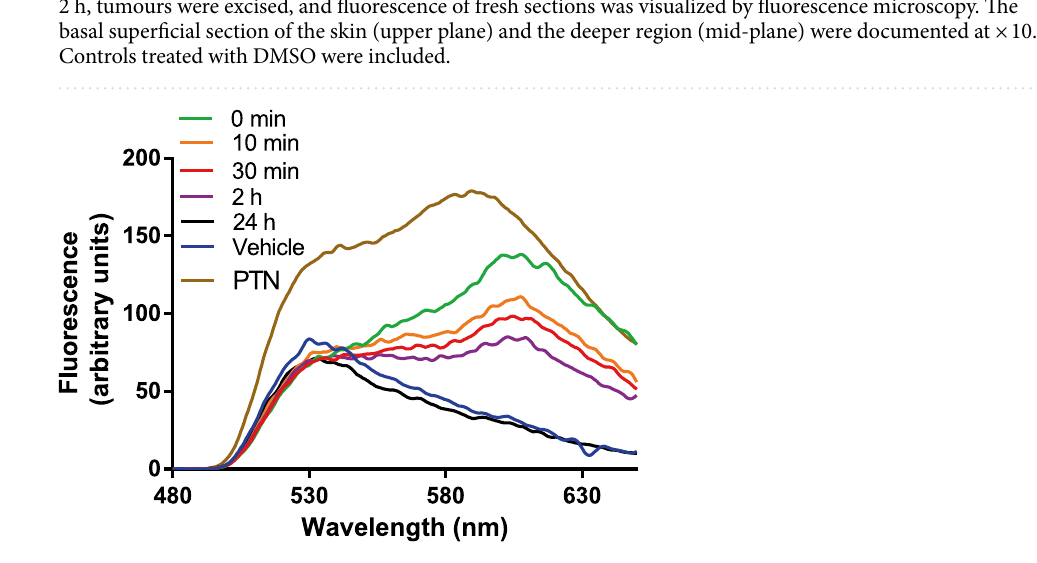
Figure 6. Kinetics of PTN penetration through the skin overlying the tumour. After topical application of PTN (1.96 mg in DMSO) on the skin over the tumour, fluorescence spectra of the AQ were recorded at the skin surface at different time points utilizing an optic fiber coupled to a spectrofluorometer. The decrease of superficial fluorescence accounts for the penetration of the molecule to inner tissue. Controls treated with DMSO (vehicle) and a fluorescence spectrum of PTN in DMSO (PTN) are included. Representative spectra are